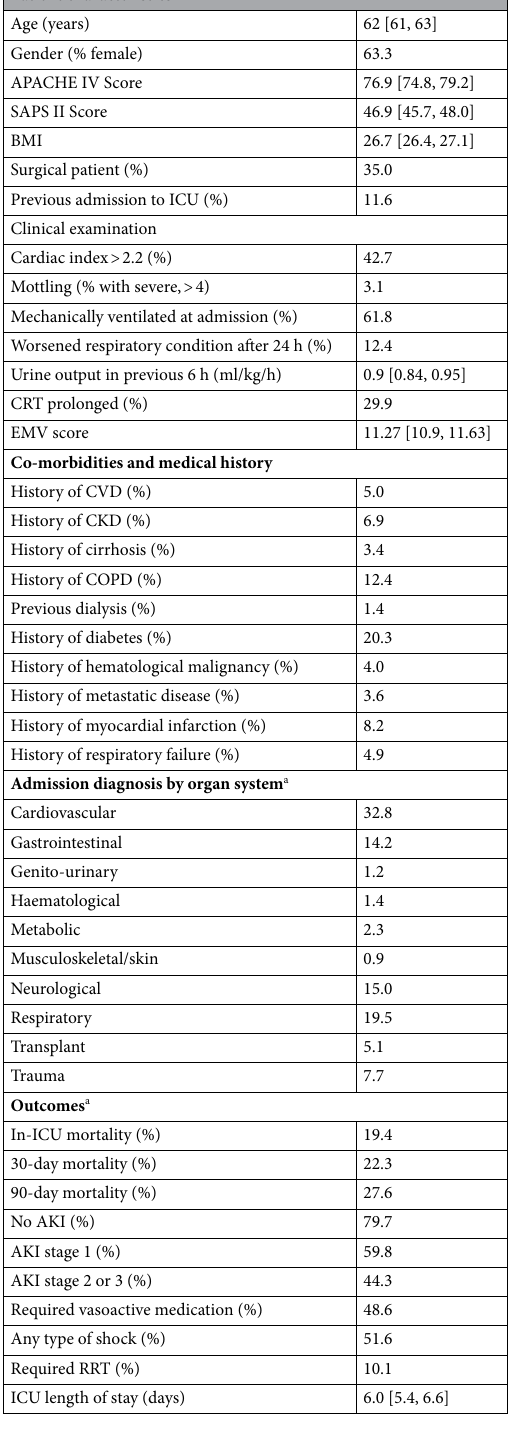
Table 2. Clinical characteristics for the 743 patients, including patient characteristics, clinical examination data, co-morbidities and medical history, and outcomes. a Denotes variables not included as input for clustering